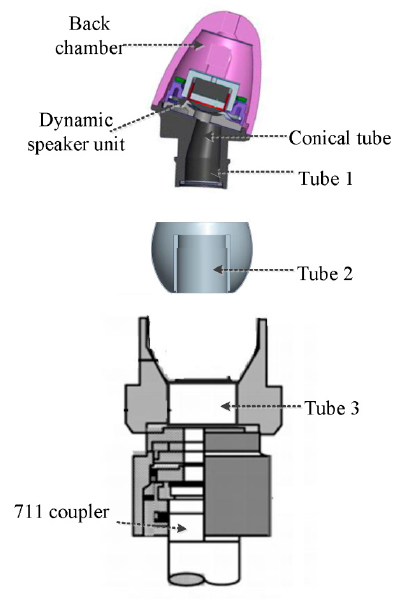
Figure 7. Cross-section view of dynamic earphone experiment condition. 图 7